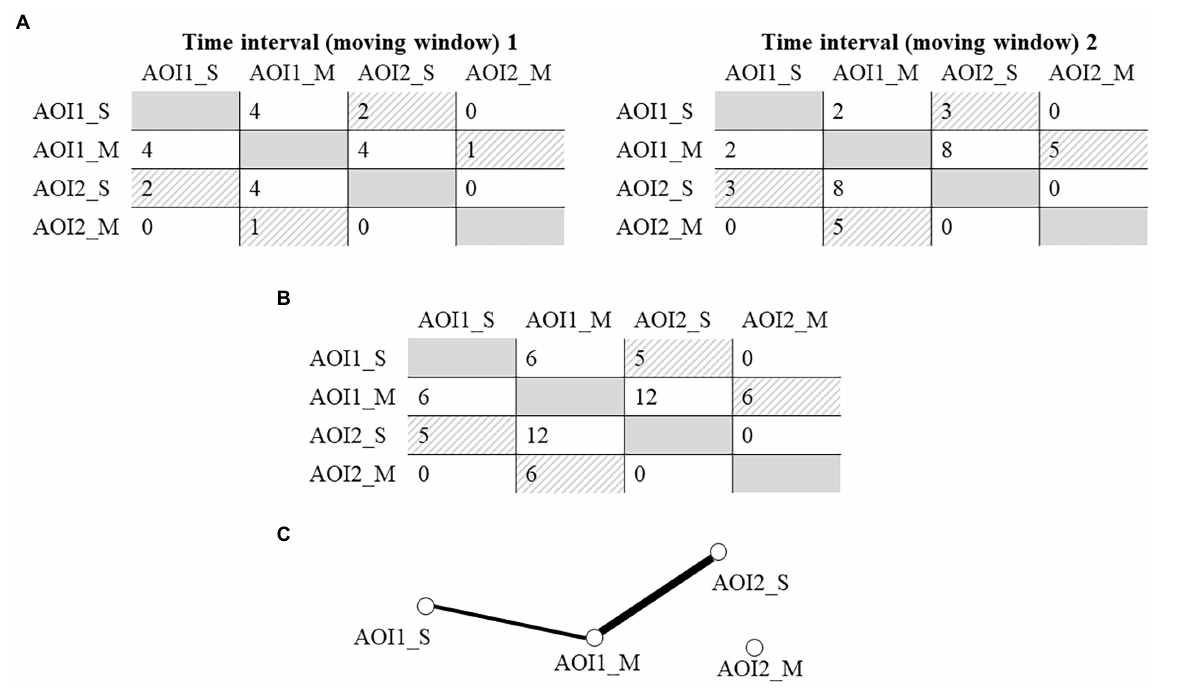
FIGURE 3 A fictional, simplified process for visualizing the epistemic network of two areas of interest (AOI1 and AOI2). S and M after the underscore refer to the gaze of the sharing student and monitoring student. (A) Weighted adjacency matrices represent the co-occurrences of gaze events in the two different time intervals (moving windows). (B) The cumulative adjacency matrix is calculated by summing the adjacency matrices presented in (A) . The connections in the AOIs between the sharing and monitoring students are included in further analyses; the connections within an individual student are excluded (see the shadings in the matrices). (C) The arbitrary visualization of the epistemic network shows that the connections between AOI2_S and AOI1_M were stronger (a thicker edge between the nodes) than the connections between AOI1_S and AOI1_M (a thinner edge between the nodes). The sharing student focused their attention neither on the AOI1_S nor on the AOI2_S when the monitoring student was looking at